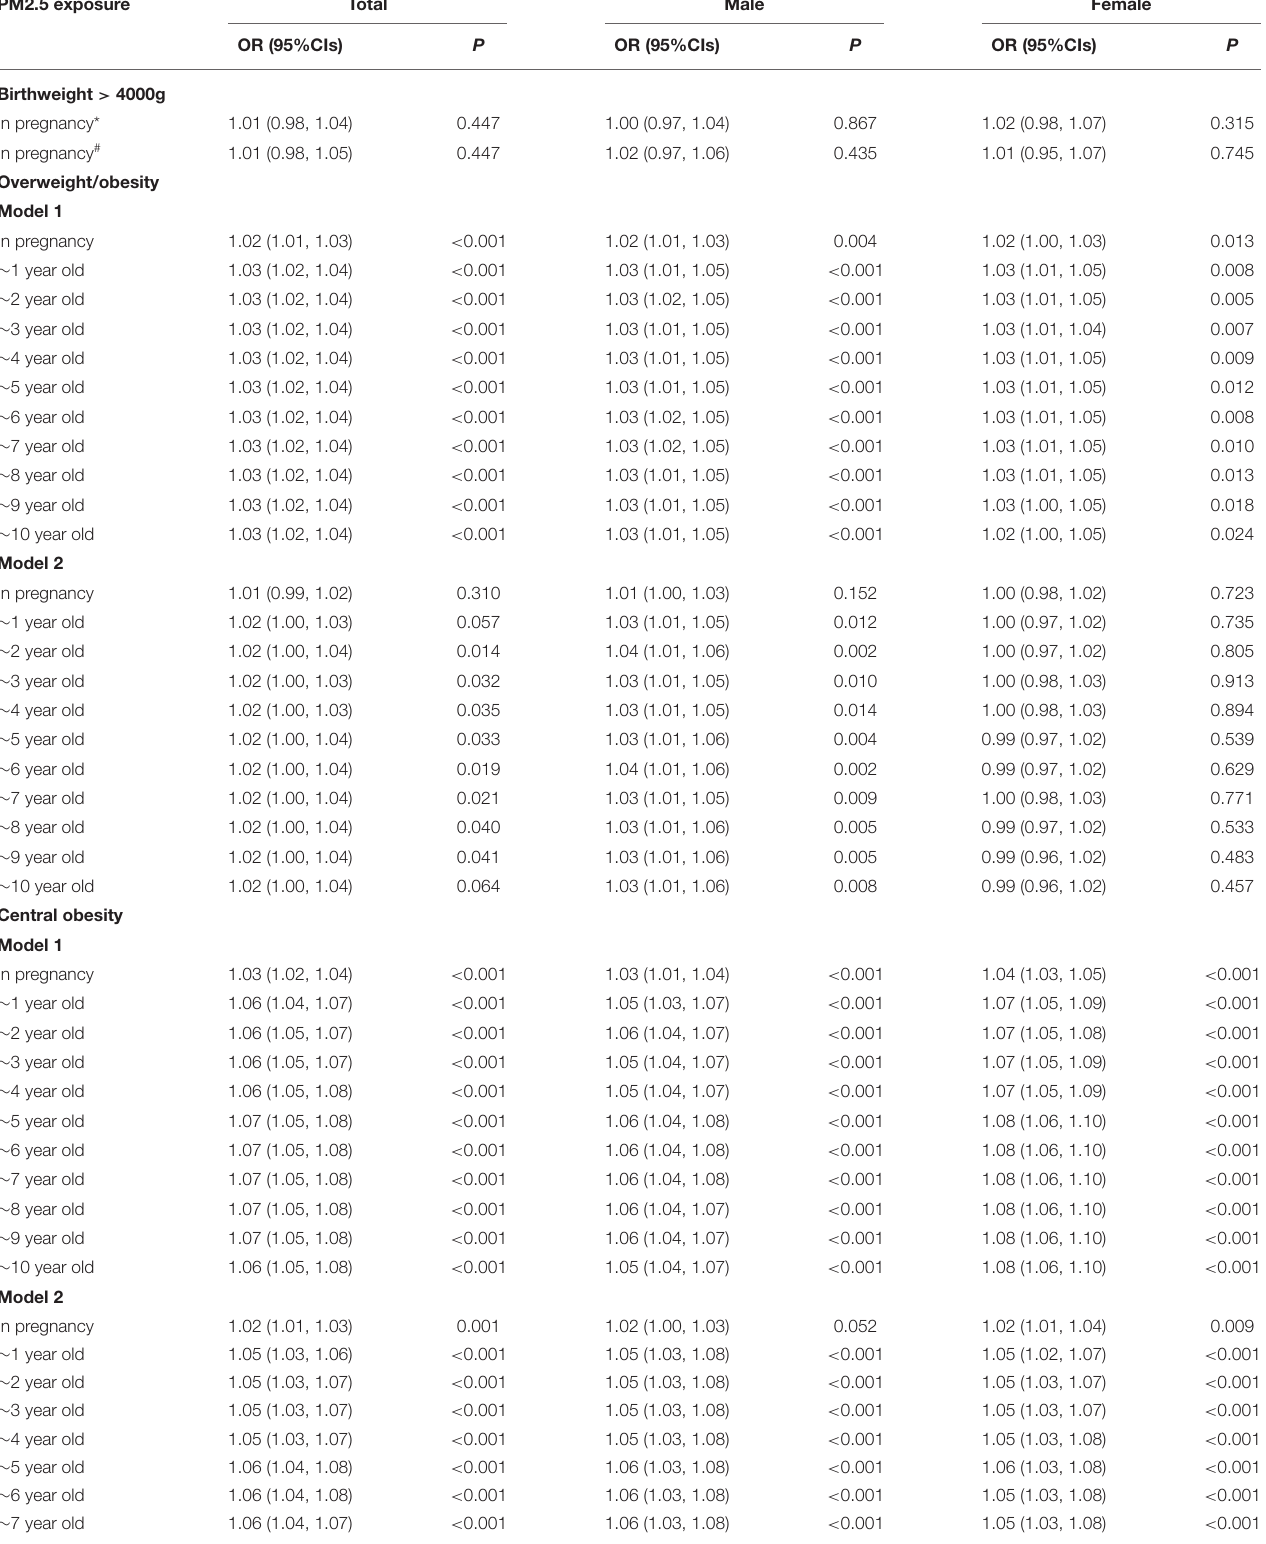
TABLE 5 | The long-term effect of PM2.5 on overweight/obesity and central obesity using mixed logistic regression analyses. PM2.5